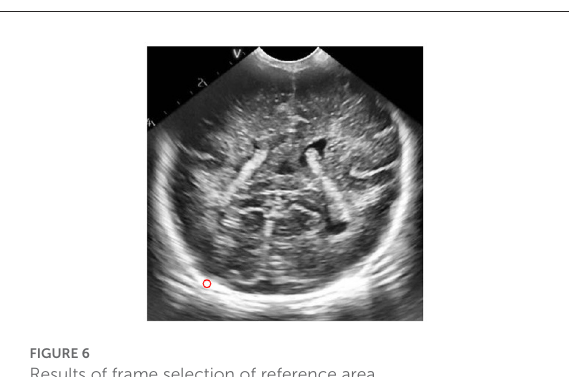
contrast adaptive histogram equalization method to enhance its